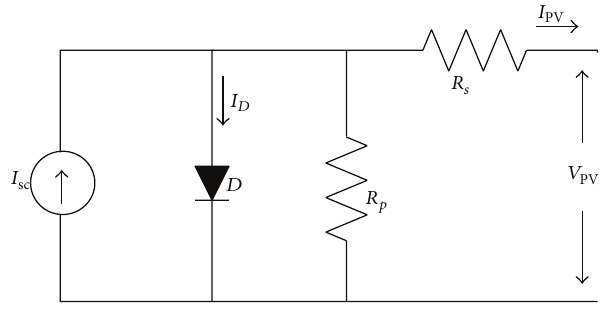
Figure 1: Equivalent circuit of solar PV